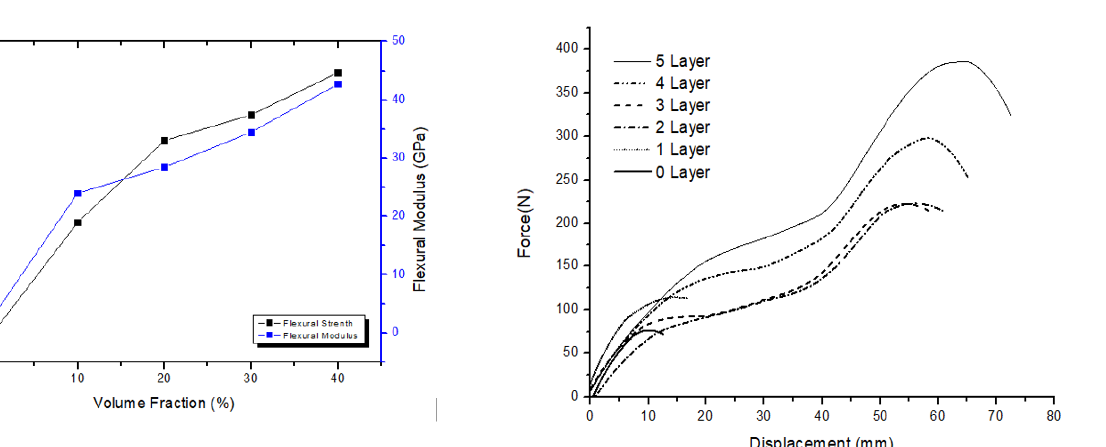
Fig. 4. Flexural strength and flexural modulus of RCF/Polyeste